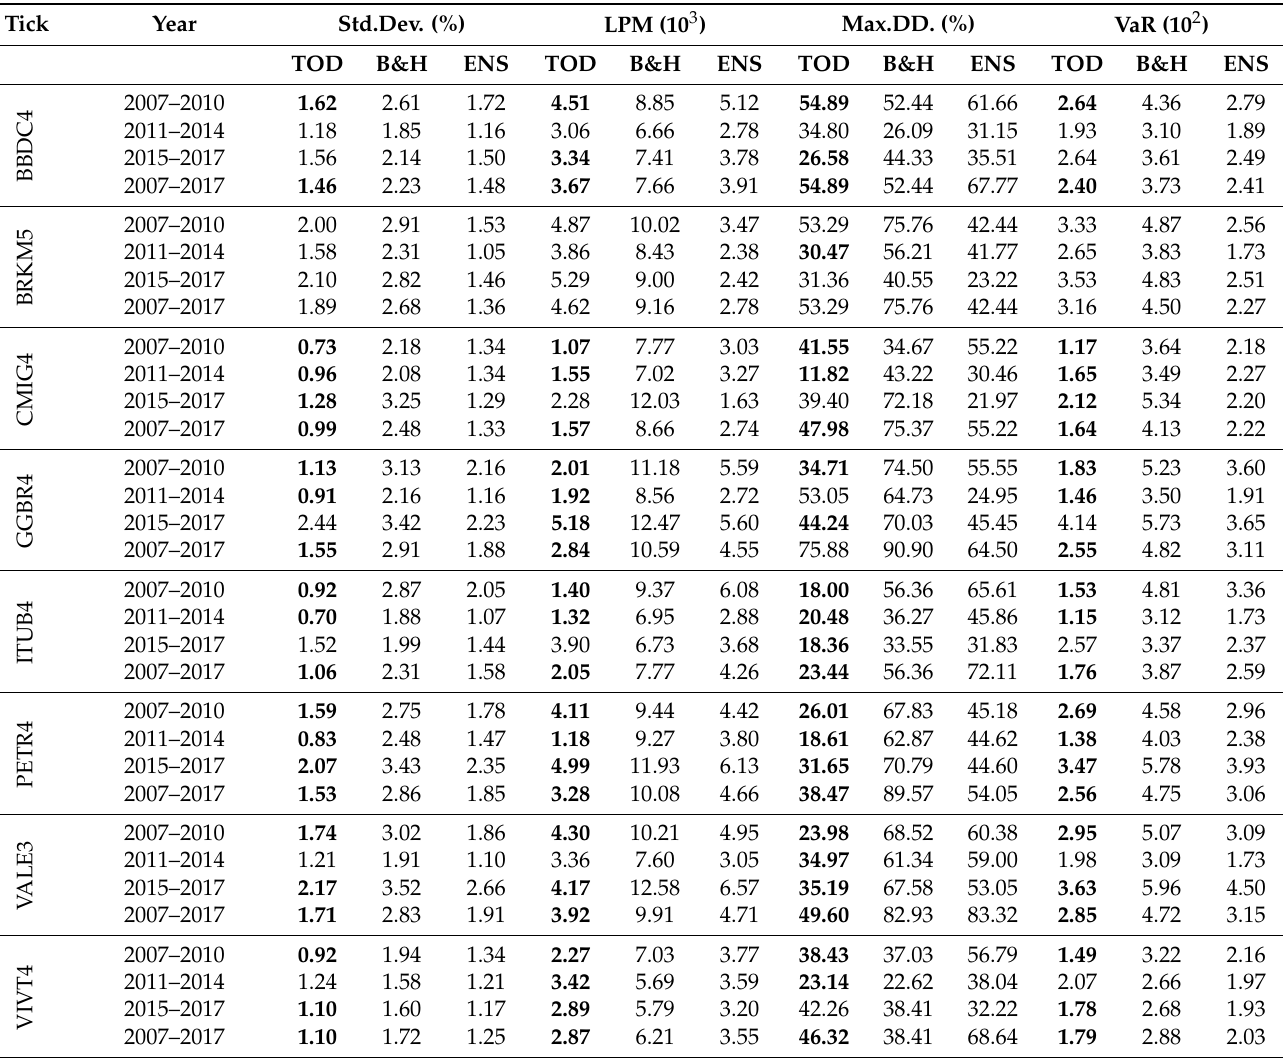
Table 2. Risk metrics. (By the